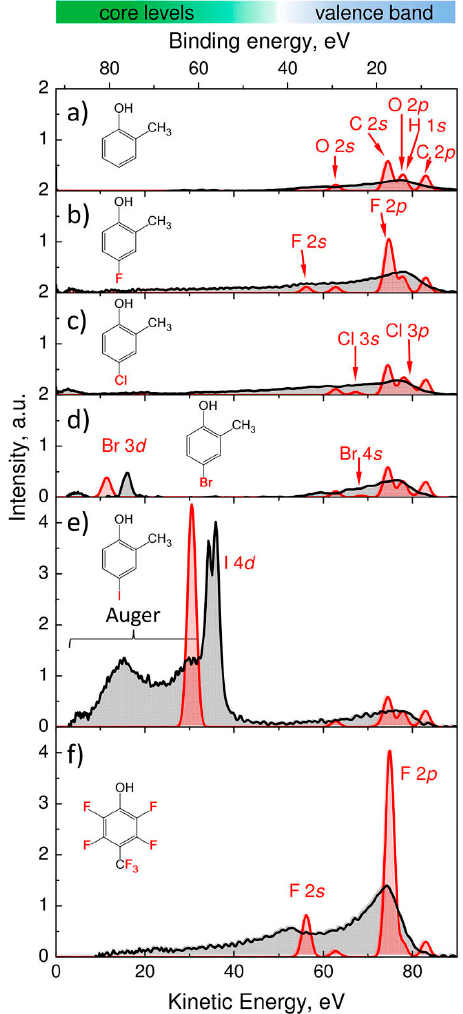
Figure 3. Photoelectron spectra of gas-phase molecules measured using 13.5 nm (92 eV) EUV radiation. Adapted from [29], with permission from AIP publishing, 2020. The kinetic energy of photoelectrons is shown in x axis. The black line corresponds to experimental data, and the red line corresponds to the model. ( a ) 2-methylphenol, ( b ) 4-fluoro-2-methylphenol, ( c ) 4-chloro-2-methylphenol, ( d ) 4-bromo-2-methylphenol, ( e ) 4-iodo-2-methylphenol, and ( f ) 2,3,5,6-tetrafluoro-4-(trifluoromethyl)phenol. The presented data